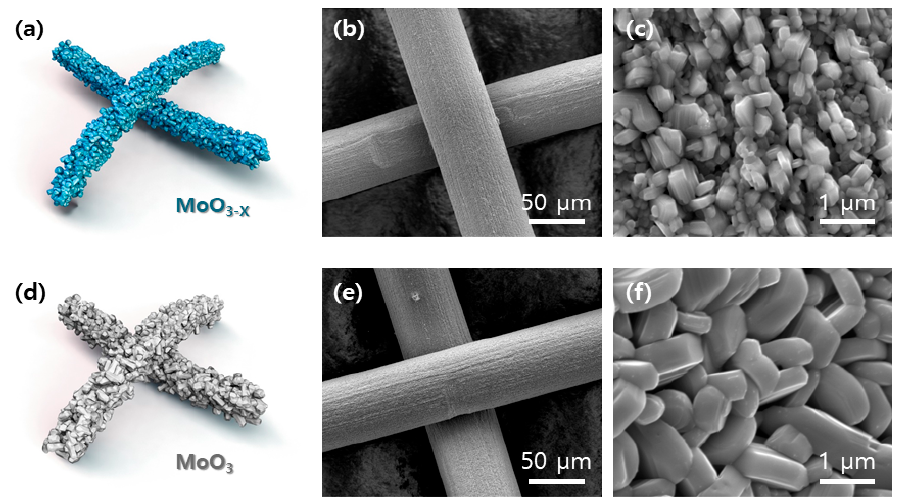
Figure 2. Schematic illustration of the as-prepared ( a ) MoO 3 − X and ( d ) MoO 3 electrodes. Low-magnification scanning electron microscopy (SEM) images of ( b ) MoO 3 − X and ( e ) MoO 3 . High-magnification SEM images of ( c ) MoO 3 − X and ( f ) MoO 3 .